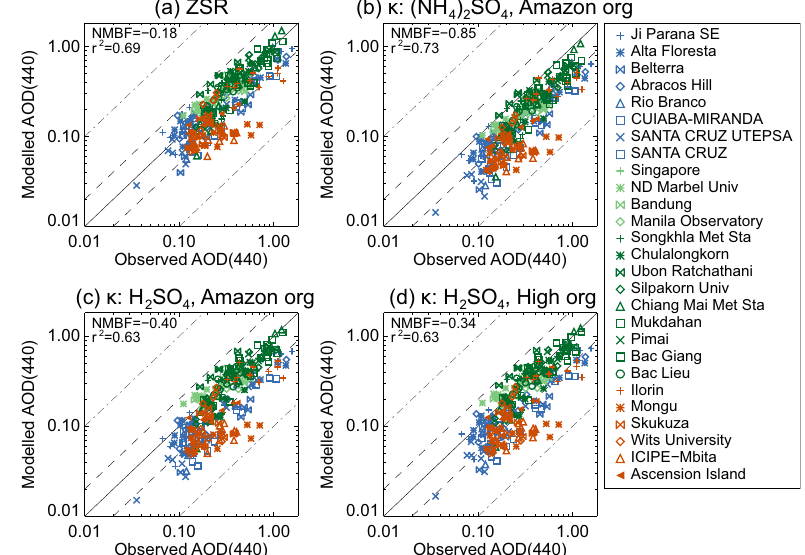
Figure 7. Simulated vs. observed multi-annual monthly mean AOD at 440nm at each AERONET station to demonstrate the sensitivity of simulated AOD to the calculation of aerosol water uptake. The model is with FINN1 fire emissions and simulated AOD is calculated assuming internal mixing with (a) ZSR water uptake scheme (identical to Fig. 5d); (b) κ -Köhler water uptake scheme: κ SO = 1 . 19, κ = 0 . 1; and (d) κ -Köhler water uptake scheme: κ Köhler water uptake scheme: κ SO POM 4 stations located in South America are shown in blue, stations in Southeast Asia are shown in green (stations in equatorial Asia and Indochina in light and dark green, respectively), and stations in Africa are shown in orange. The normalised mean bias factor (NMBF) and Pearson’s correlation ( r 2 ) between modelled and observed PM 2 . 5 concentrations are shown in the top left